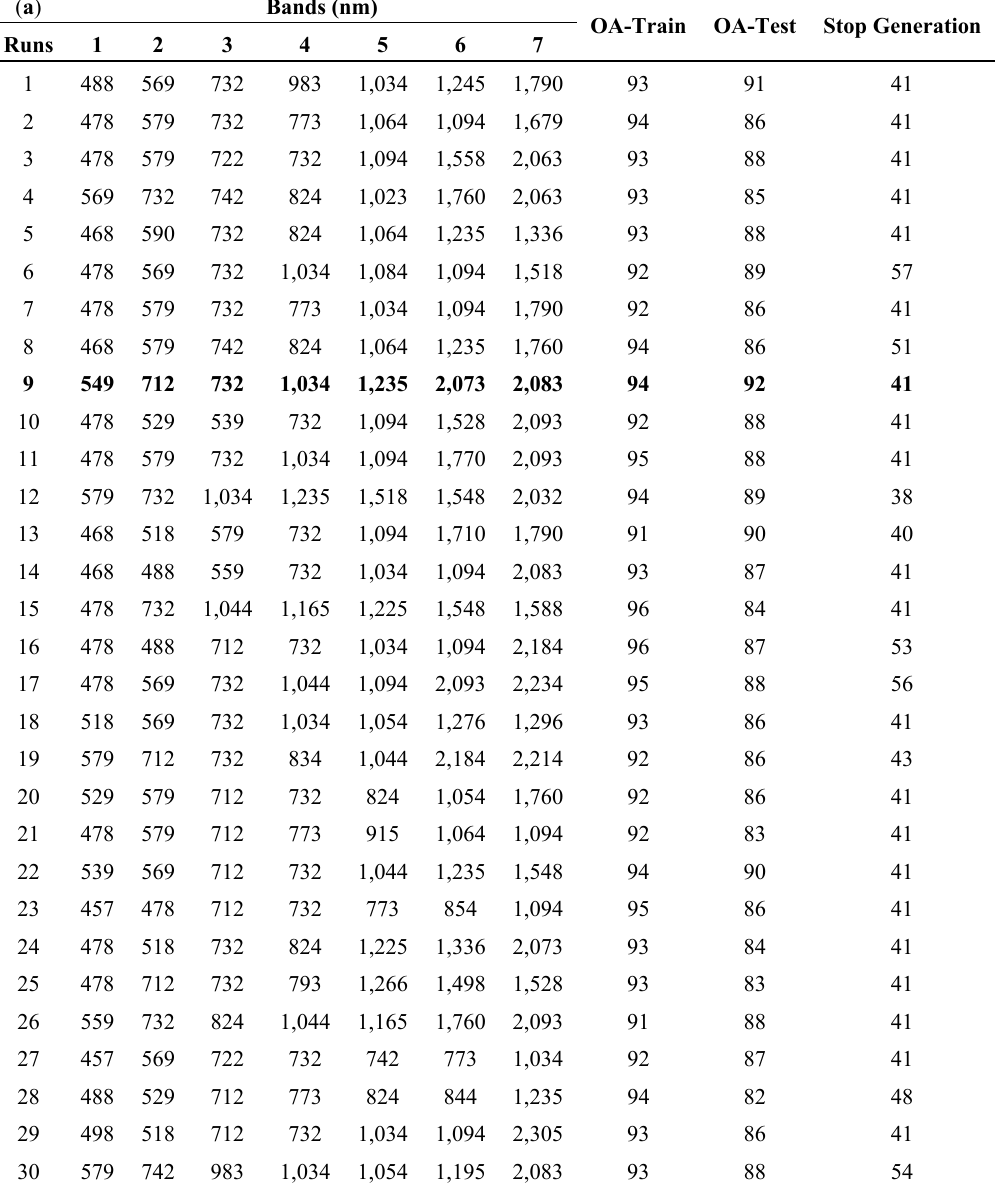
Table 2. ( a ) The performance of the 7-channel chromosome (the winning chromosome) after rotating the input data for 30 times with the best band combination highlighted in bold typeface; ( b ) The performance of the 7-channel features selected by the SFS method with the best band feature highlighted in bold typeface under a data rotation scheme. OA = Overall